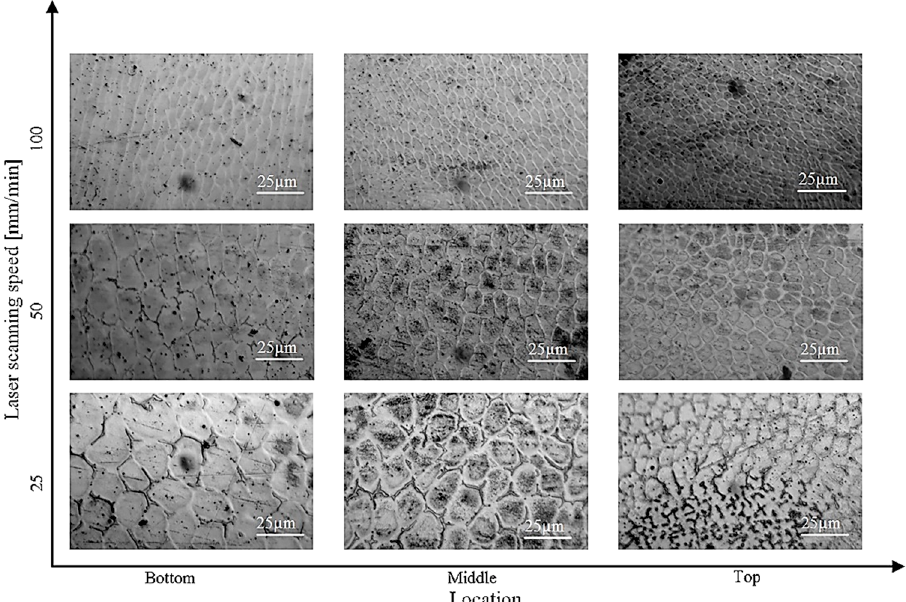
Figure 13. Evolution of as-printed SS 316L sample microstructures with varying scan speeds and at different build height locations [182].